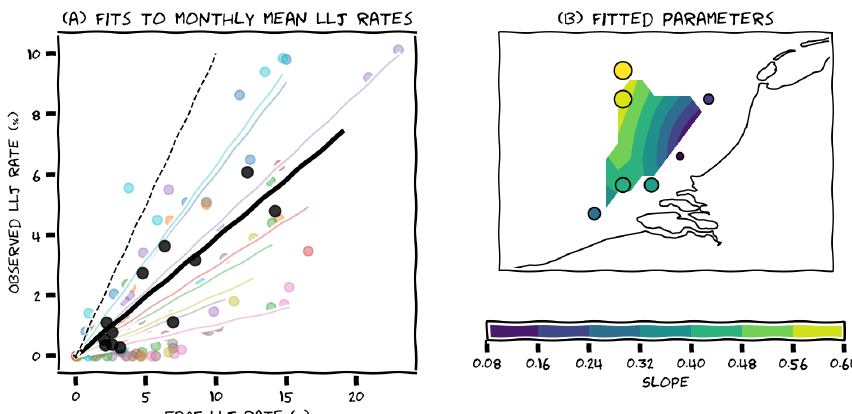
Figure 7. (a) Illustration of linear regression between monthly low-level jet rates in the ERA5 data (subset, up to 500m) and the observations. Black line and scatter points represent aggregated data of all platforms, while the other colours correspond to fits for individual platforms. Dashed black line indicates a 1 : 1 correspondence. (b) Spatial distribution of the obtained fit parameters for each individual platform. Like the colour coding, marker size is scaled with the slope of the regression.